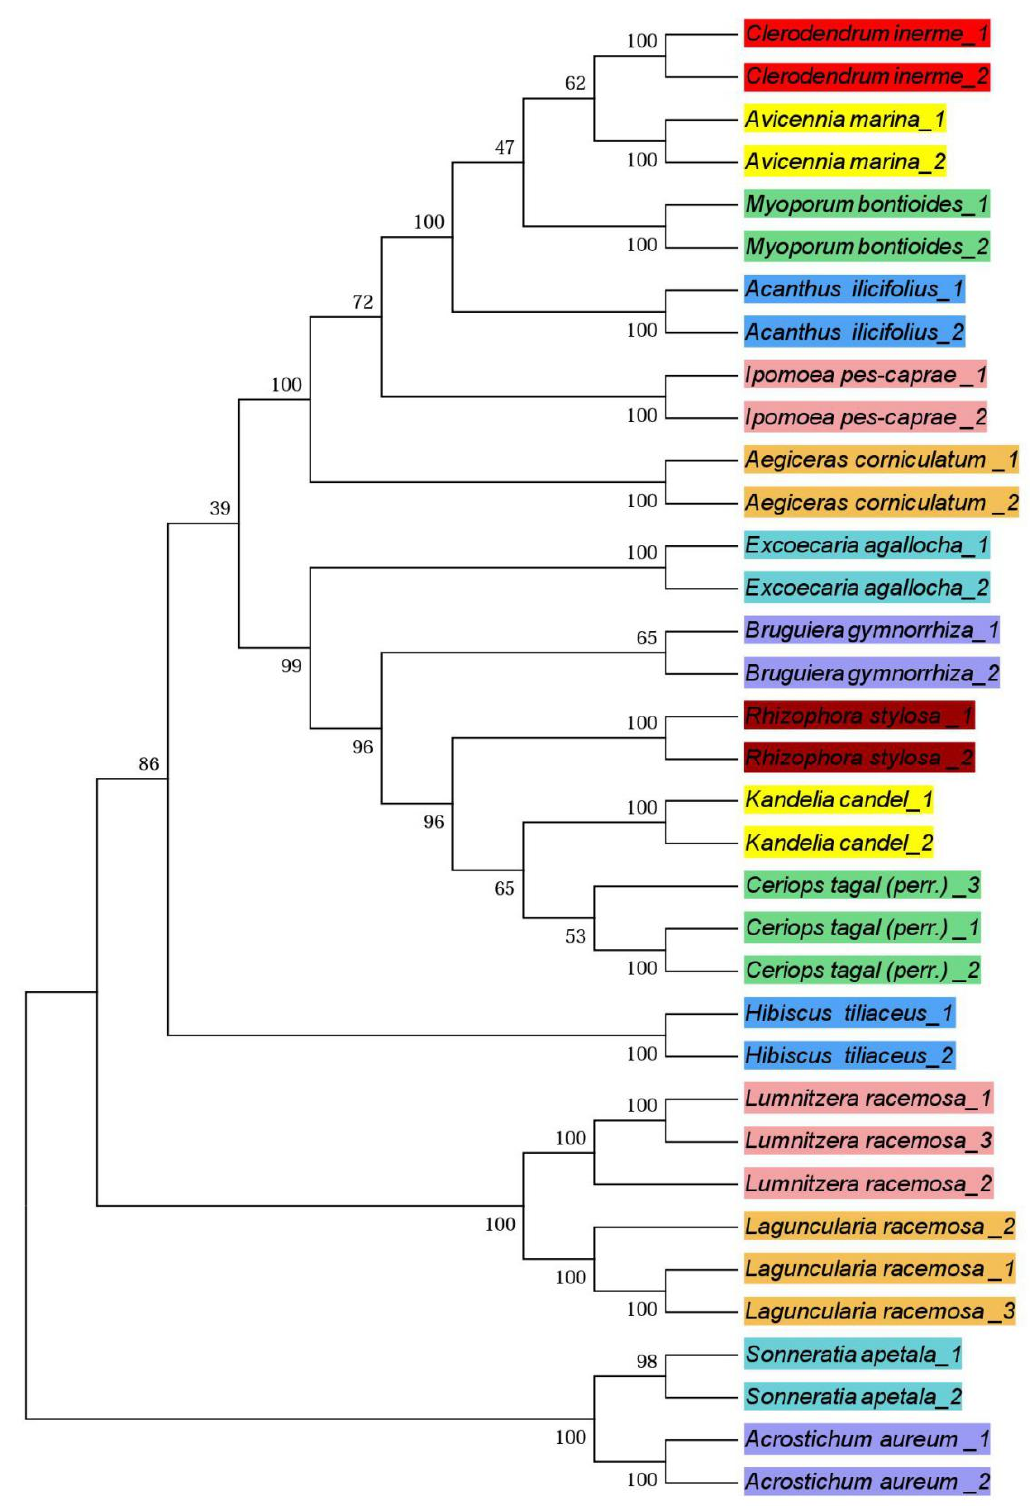
Figure 2. The phylogenetic tree of mangroves in Zhanjiang using fragment of matK + rbcL + trnH-psbA + ITS.